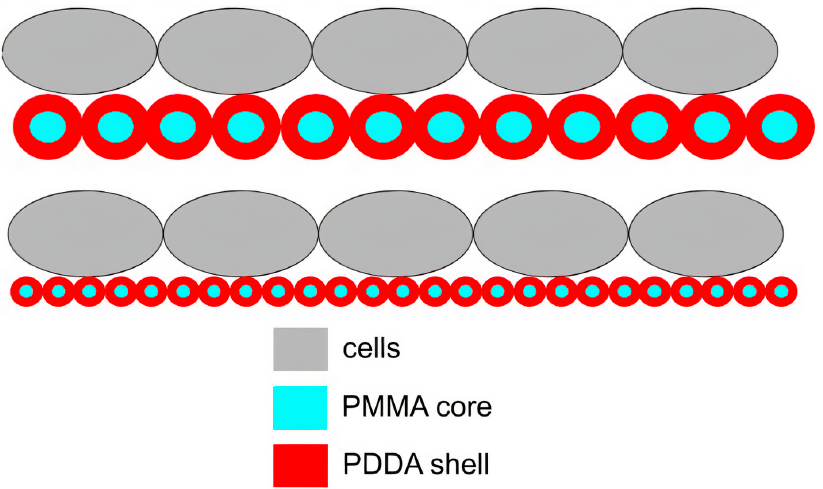
Figure 11. Scheme for the interaction between cells and coatings cast from core − shell nanoparticles. Nanoparticles in the coatings optimized antimicrobial activity due to a higher frequency of multipoint interactions between poly (diallyl dimethyl ammonium) chloride (PDDA) shell (in red) and cells (in grey) than the one for the larger particles. Reproduced from [31].